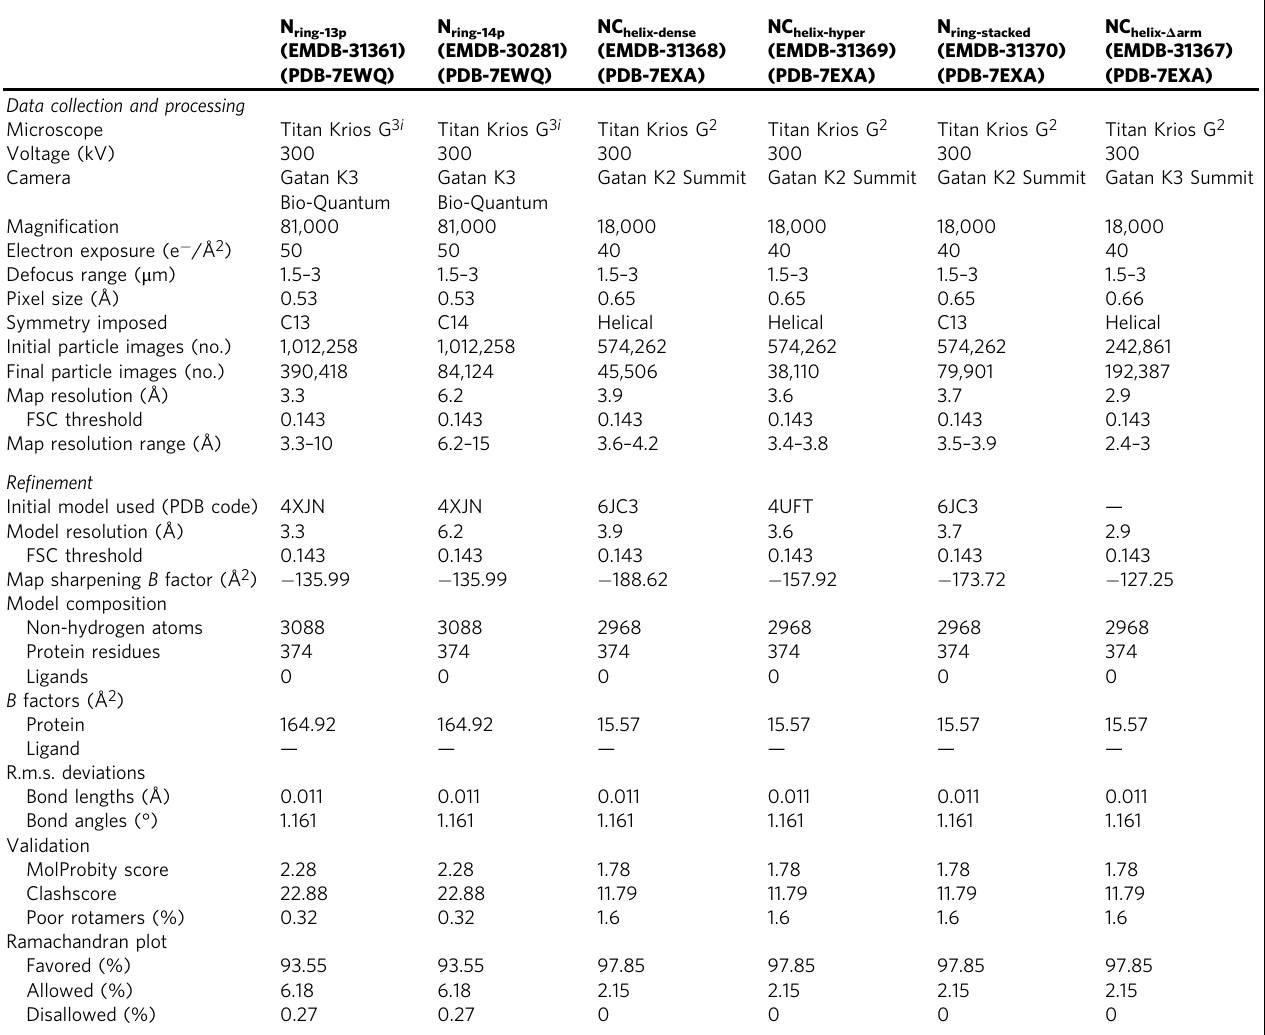
Table 1 Cryo-EM data collection and data processing statistics.